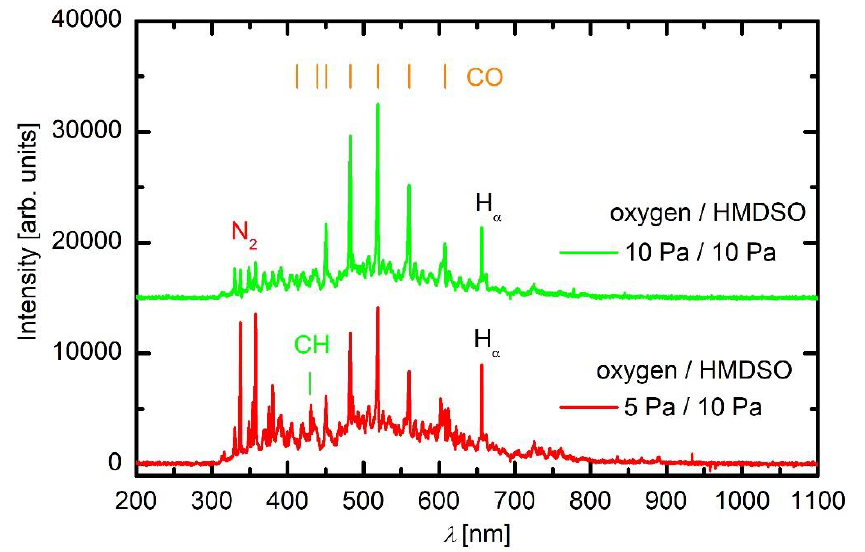
Figure 5. A spectrum of plasma in oxygen / HMDSO mixture 1 / 2 (bottom curve) and 1 / 1 (top curve) at 200 W.